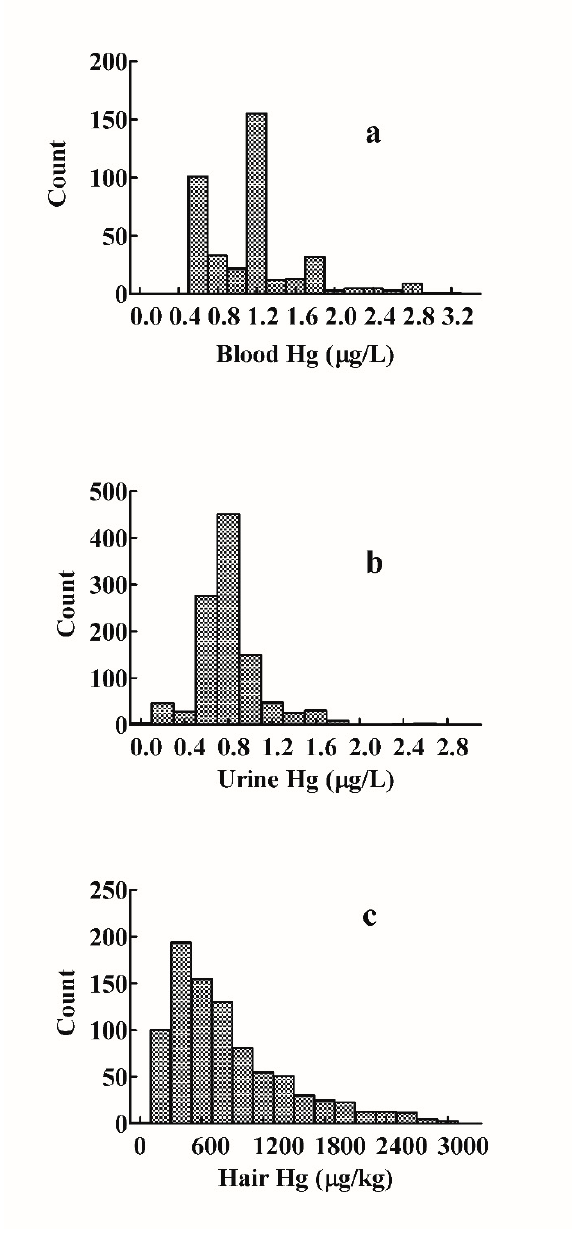
Figure 1. Distribution of mercury levels for children in Xiamen, China: ( a ) blood analysis: n = 395; ( b ) urine analysis: n = 1072; ( c ) hair analysis: n =